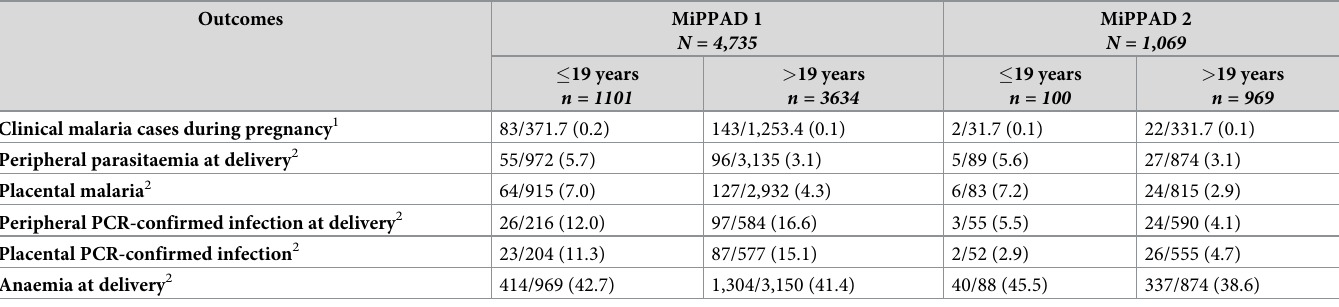
Table 3. Malaria in pregnancy prevalence and incidence by trial and age group